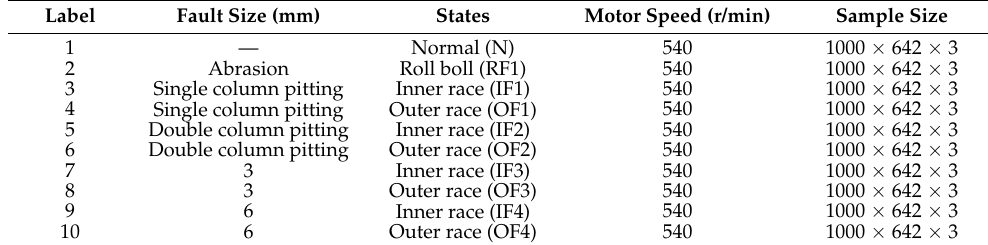
Table 7. Dataset B: Experiment bearing operation states.